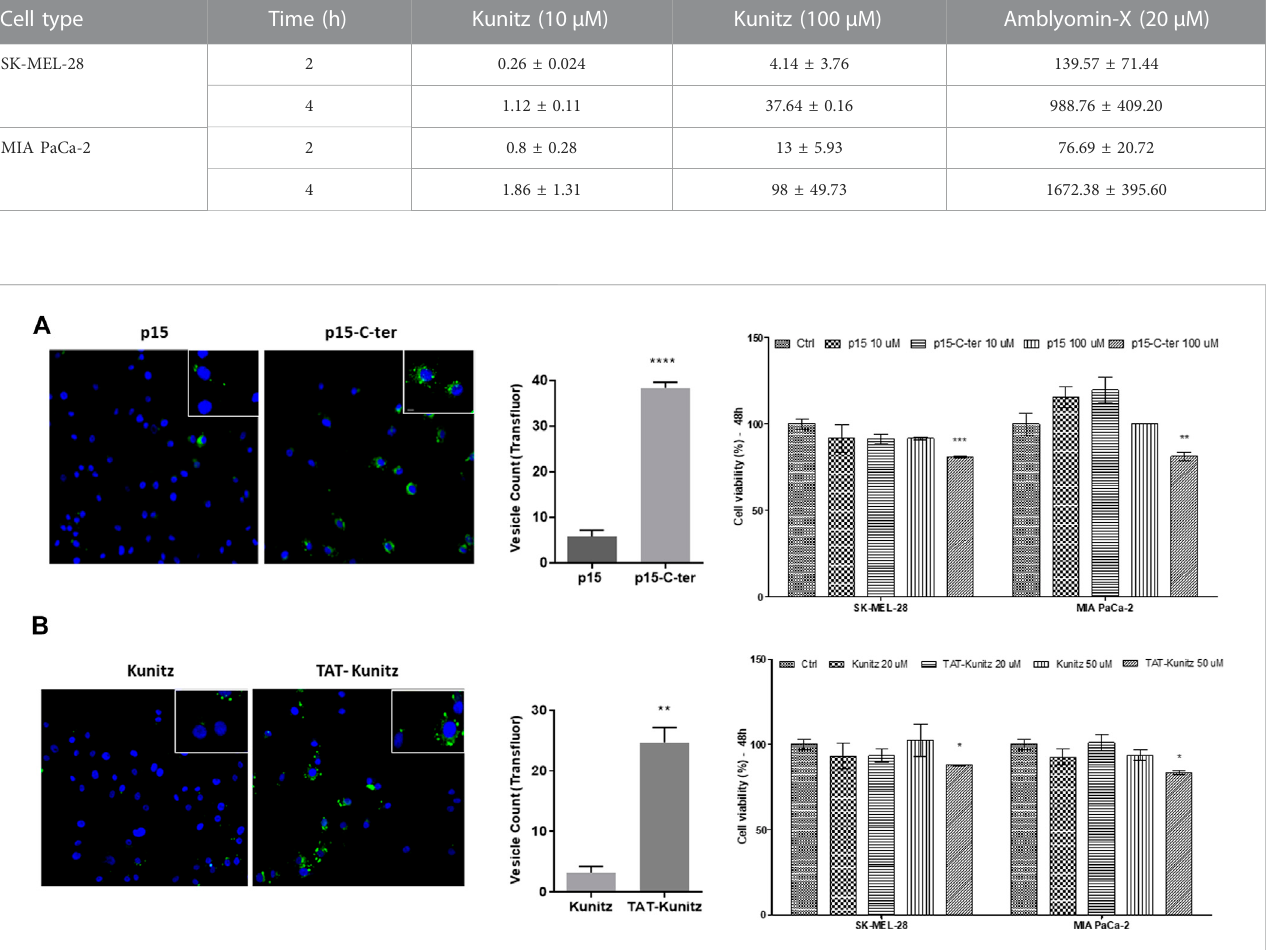
FIGURE 7 Cargo-delivery ability of C-ter and intracellular detection of TAT-Kunitz. (A) SK-MEL-28 cells were treated with p15 or P15-C-ter both Alexa Fluor 488- labeled for evaluation of its uptake and cell viability was investigated by MTT assay. (B) Kunitz uptake and cytotoxicity by using TAT CPP delivery tool. In all approaches, nuclei were stained with Hoechst 333422 and green fl uorescence was monitored by a Molecular Devices ImageXpress Micro Confocal plate- scanning microscope. Vesicles were de fi ned using MetaXpress software (Molecular Devices, Sunnyvale, CA) with Trans fl uor Application Module. Values are mean ± SD of three independent experiments (each one carried out using nine fi elds per well and in triplicate). * p ≤ 0.05; ** p ≤ 0.01 and *** p ≤ 0.001 (comparing CPP-conjugated molecule vs.